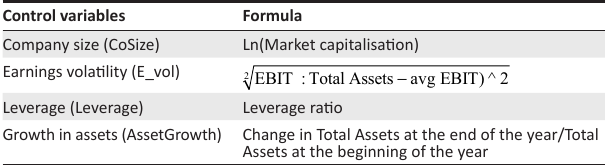
TABLE 1: Proxy for control